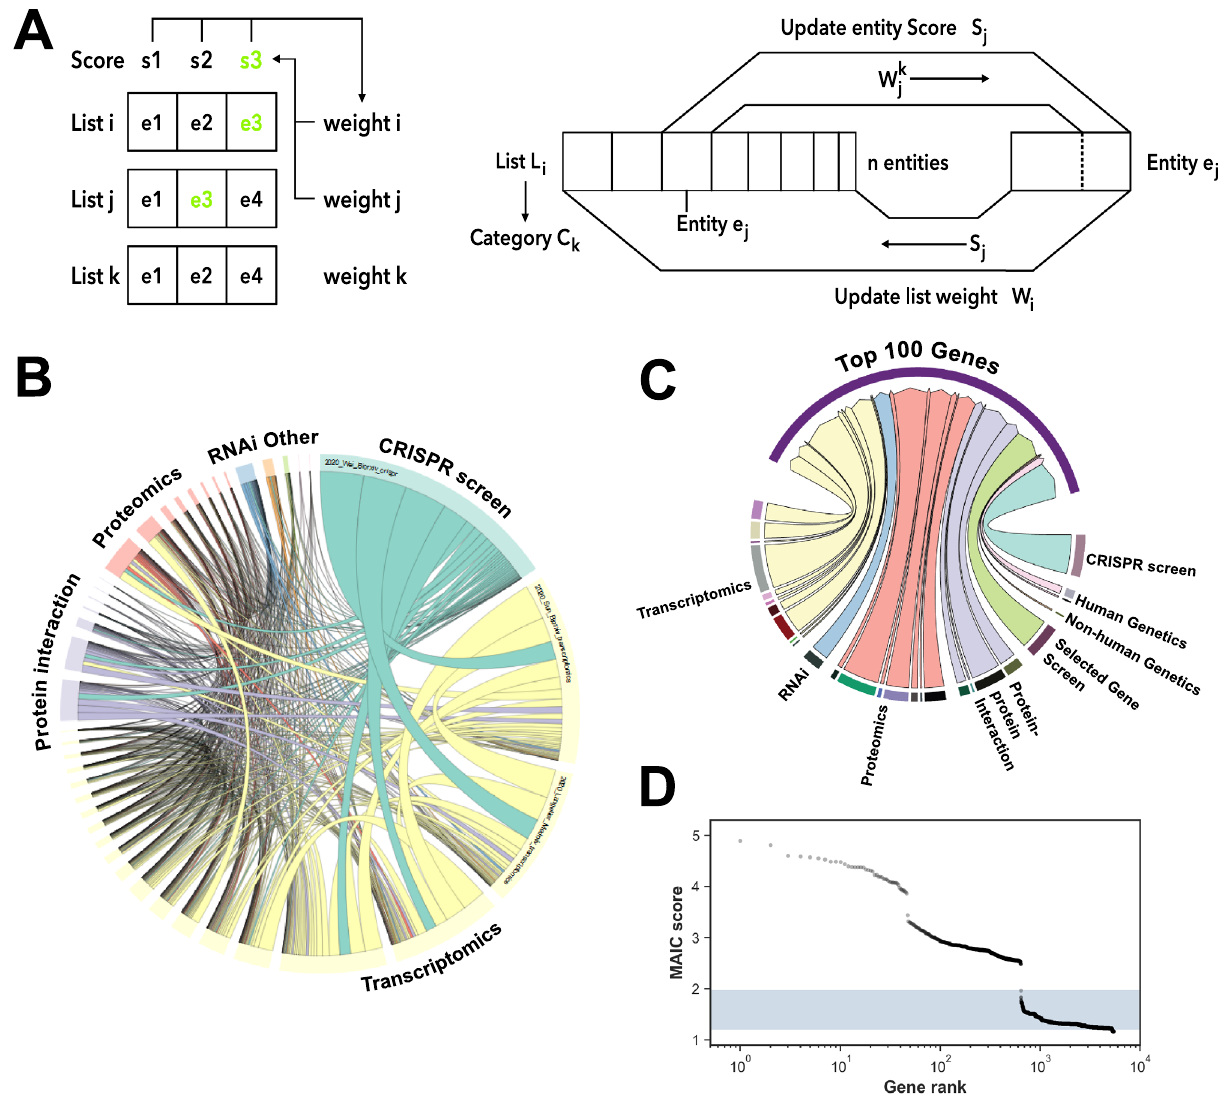
Figure 1. Overview of MAIC approach. ( A ) Schematic showing the operation of MAIC. Each entity in a list is given a score, based on overlap with other lists and rank where relevant, and each list is given a weight determined by the scores of its constituent entities. Entity scores are iteratively updated using list weights, and list weights are updated using entity scores, until convergence occurs. ( B ) Circular plot showing overlap between different data sources included in MAIC. Size of data source blocks is proportional to the summed information content (MAIC scores) of the input list. Lines are coloured according to the dominant data source. Data source categories share the same colour; the largest categories and data sources are labelled (see Supplementary Information for full source data). ( C ) Relative information contributions (determined by sum of MAIC score contributions) of each experimental category to the evidence base for the top 100 genes in the MAIC output. ( D ) Distribution of MAIC scores by gene rank. The shaded region indicates the range of possible scores for a gene supported by a single gene list only. Beyond ranks around 700 in this study, gene scores approach baseline, indicating they have little corroborative mapped to their human homologues using the NCBI Homologene database 11 , or excluded from the analysis if no human homologue could be identified.